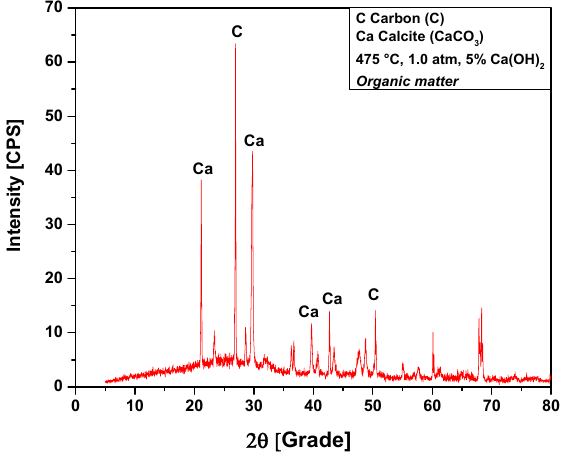
Figure 13. XRD of solid phase products by catalytic cracking of (organic matter + paper) fraction of MHSW at 475 °C, 1.0 atm, with 5.0% (wt.) Ca(OH) 2 , using a borosilicate glass reactor of 125 mL, in laboratory scale.